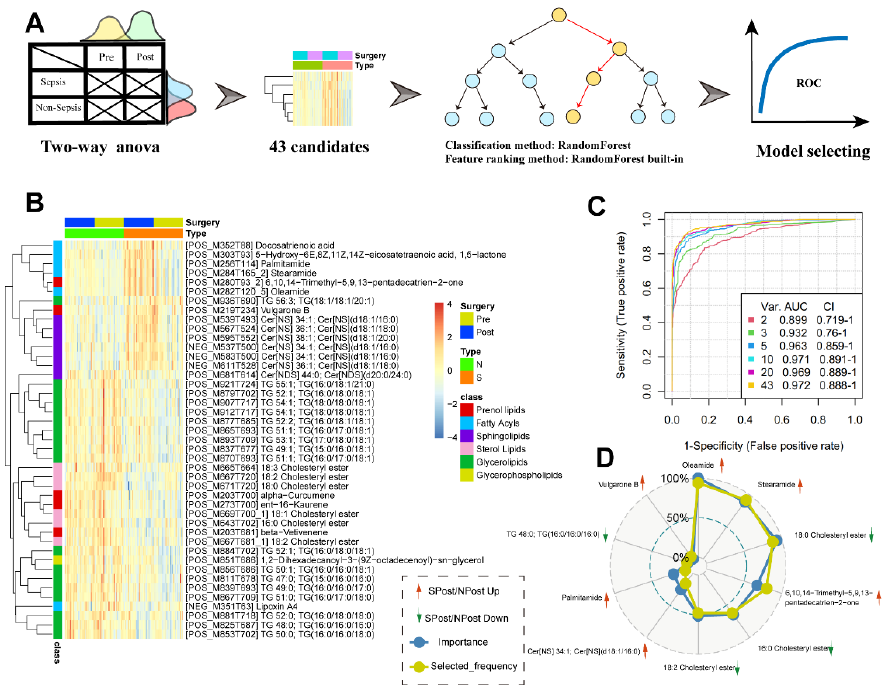
Figure 4. ( A ) A flow chart to demonstrate the main steps of signature discovery and evaluation. ( B ) Forty-three candidate signatures from two-way ANOVA. ( C ) Performance evaluation of top 2, 3, 5... 43 (max) important features to construct corresponding classification models. ( D ) Radar plots of the top 10 features with the highest selection frequency in the classification models.